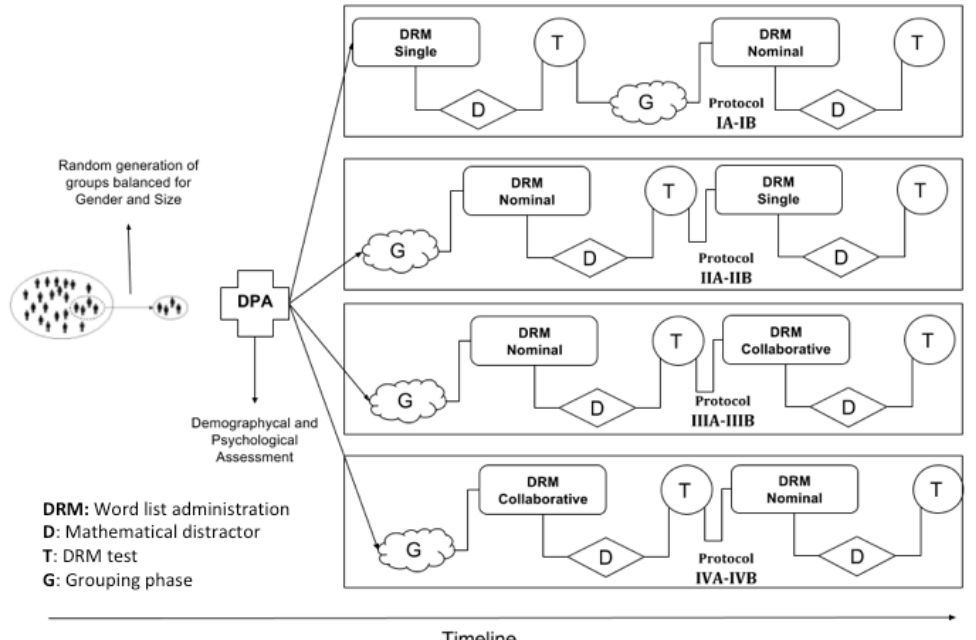
Figure 1. Experimental design. Note. In figure, the entire procedure for each protocol (i.e., Protocol IA-IB; Protocol IIA-IIB; Protocol IIIA-IIIB; Protocol IVA-IVB) is reported. Groups (i.e., subsamples) were balanced for all conditions (i.e., word list, order of experimental conditions, group size and gender